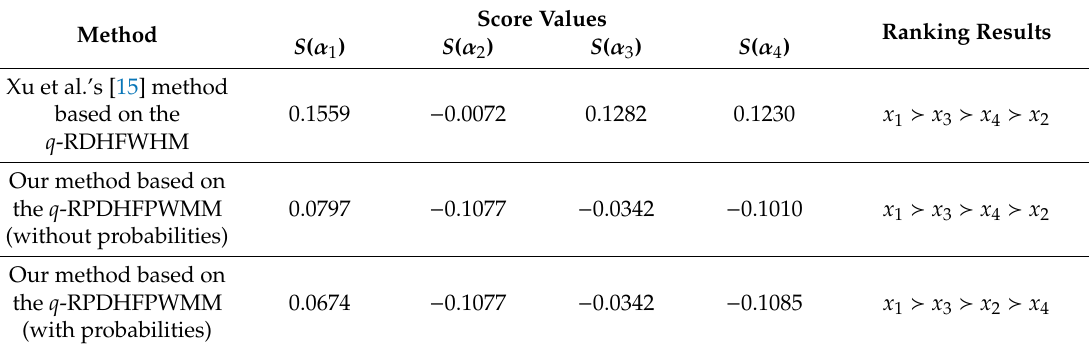
Table 12. The score values and ranking results utilizing Xu et al.’s [15] and our